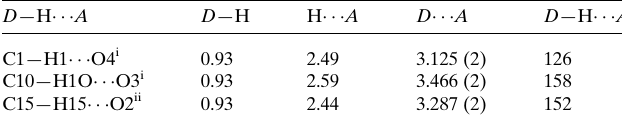
Table 1 Hydrogen-bond geometry (A˚ , (cid:2) ).